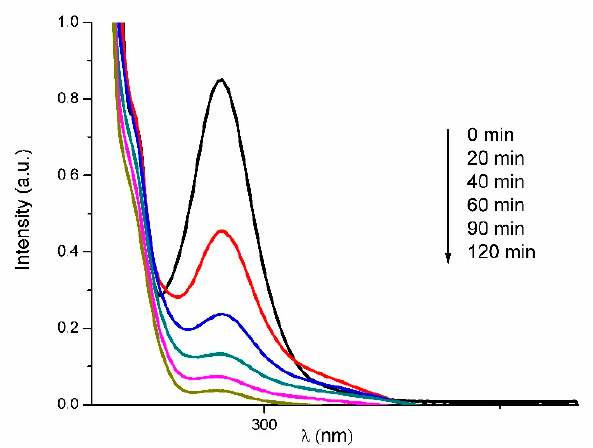
Figure 6. UV spectrum of aqueous nitrobenzene at different intervals for the photodegradation with ZnO 2 nanoparticles at optimum conditions.